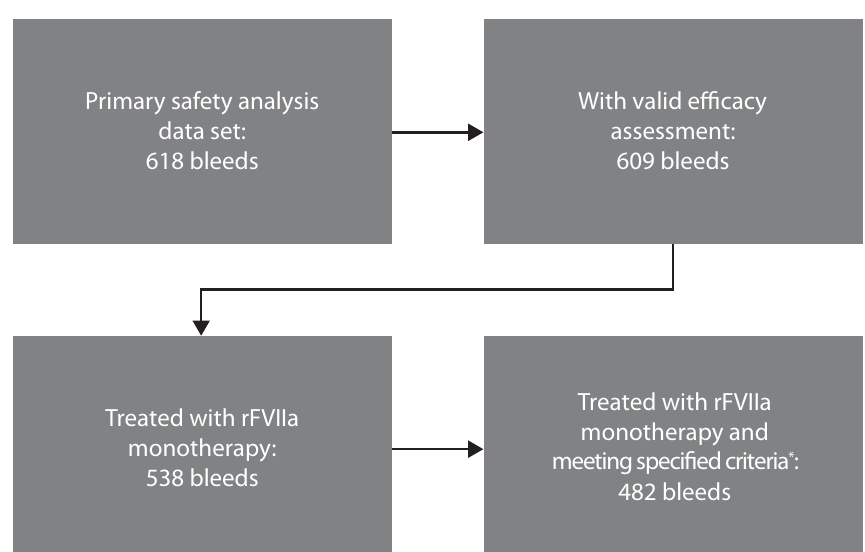
Fig. 1 SMART-7 ™ primary and post hoc subgroup analysis datasets. The primary safety analysis dataset includes 609 bleeding episodes with valid ef fi cacy assessment. 7 (cid:4) The rFVIIa monotherapy dataset includes 482 bleeding episodes with (1) valid ef fi cacy assessment, (2) no missing time for bleed start, (3) no missing time for any dose administration, and (4) valid time to fi rst treatment.